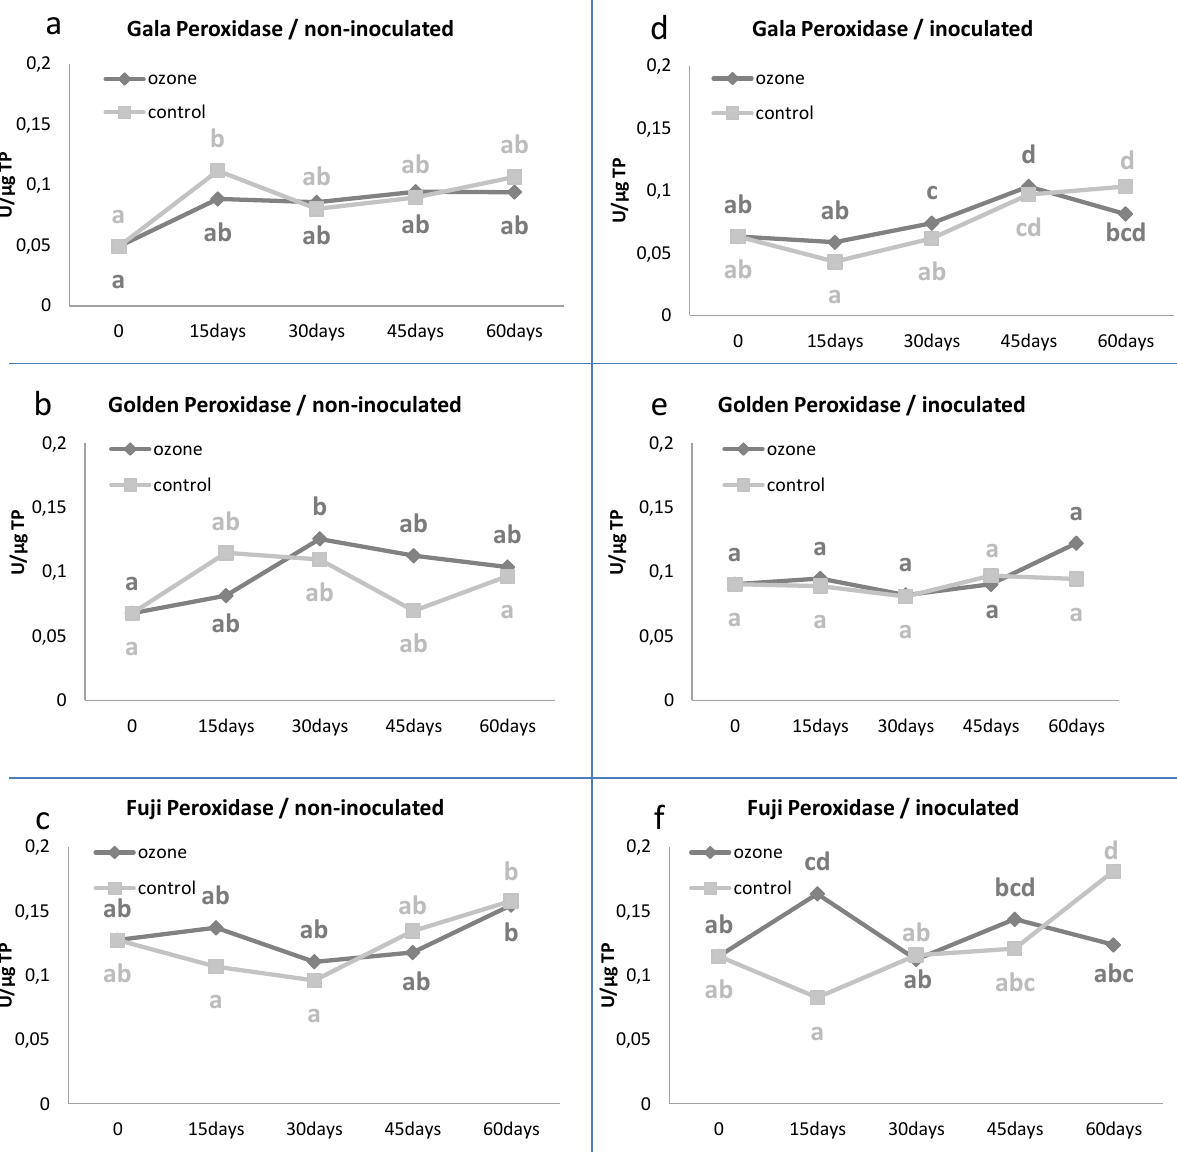
Figure 4. Mean peroxidase specific activities in non-inoculated and Penicillium expansum inoculated apple fruits (‘Royal Gala, ‘Golden Delicious, ‘Fuji’), either non-treated (a, b, c) or treated by ozone at 0,5μL L -1 (d, e, f), stored at 1°±1C in the dark. Means followed by the same letter are not significantly different (Fisher’s Least Significance Difference test (LSD, P =